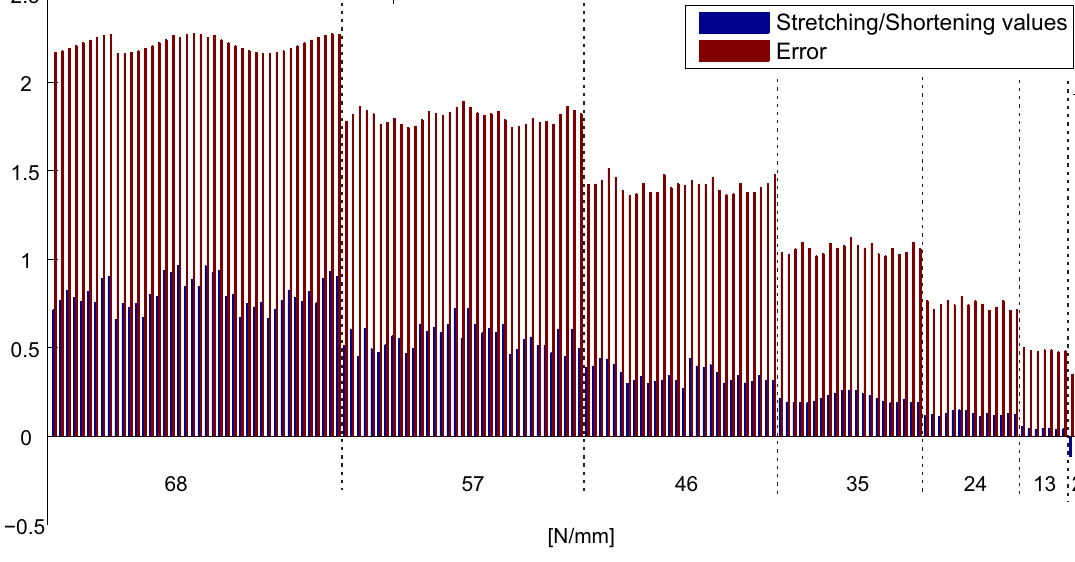
Figure 10. Error and correction values (rigid case).